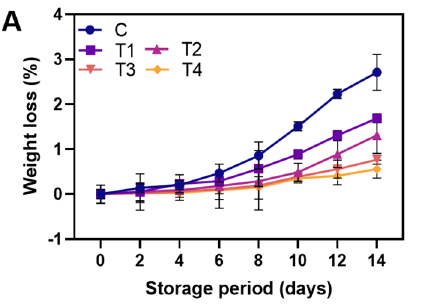
Figure 4. Changes in weight loss ( A ) and pH ( B ) of the shrimps coated with different coatings during storage of 14 days at 4 °C. C: shrimp dipped in distilled water as control; T1: shrimp coated with storage of 14 days at 4 ◦ C. C: shrimp dipped in distilled water as control; T1: shrimp coated with alginate coating; T2, T3, and T4: shrimp coated with 0.5, 1.0, and 1.5% LPE, respectively. alginate coating; T2, T3, and T4: shrimp coated with 0.5, 1.0, and 1.5% LPE,